Question: Express in one sentence what the figure is showing.
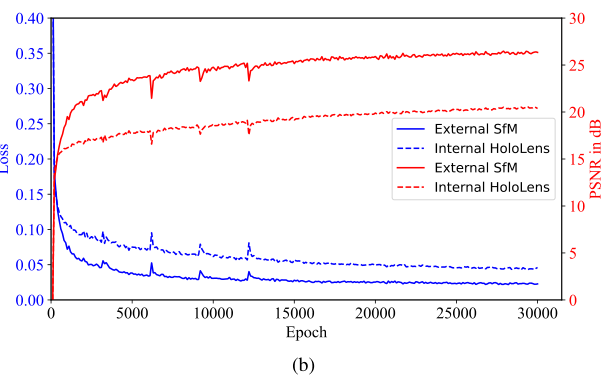
Answer: Comparison of the Peak Signal-to-Noise Ratio (PSNR) ↑in dB and loss ↓during the training processes with 30 000 it- erations with 3D Gaussian Splatting with different types of input data. Top: (a) external SfM and internal HoloLens data on scene ’Denker’. Bottom: (b) external SfM and internal HoloLens data on scene ’Ficus’. The red curves show the PSNR, the blue curves the training loss.